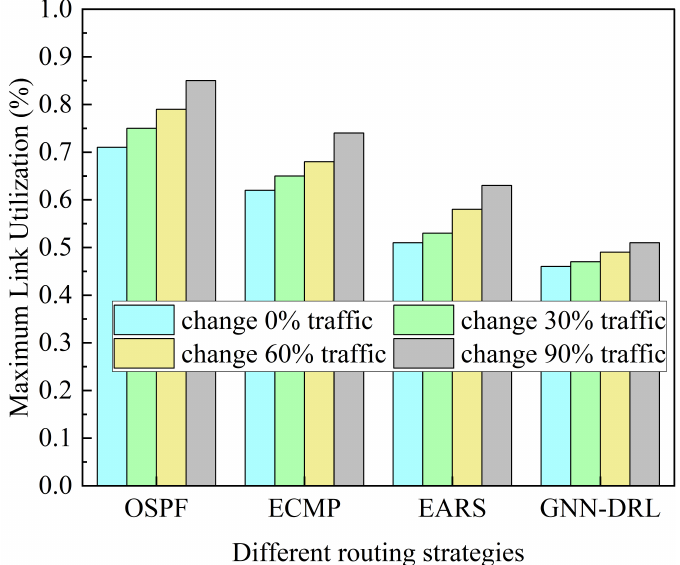
Figure 11. Optimized performance of maximum link utilization under different traffic loads.